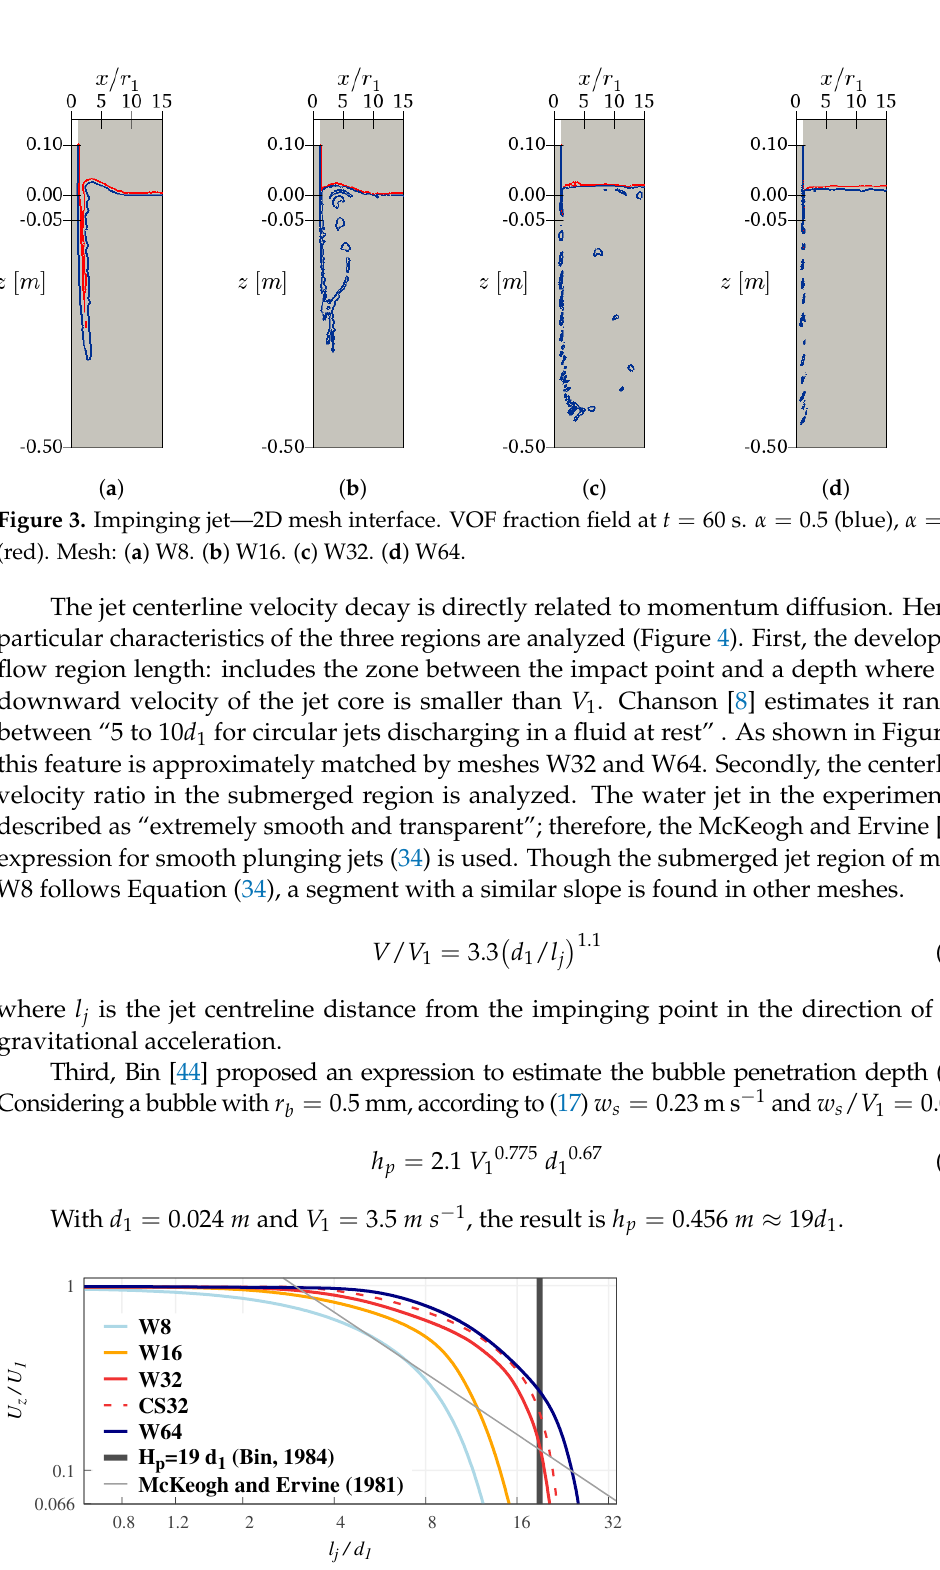
Figure 4. Impinging jet—mesh dependency: centerline velocity